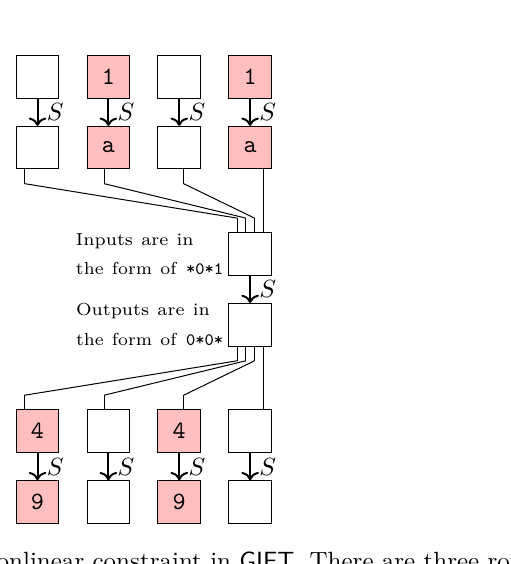
Figure 10: An example of a nonlinear constraint in GIFT . There are three rounds in the figure, focusing only on the connections of the inputs and the outputs of a single inactive Sbox in the middle round. The pink cells are the active